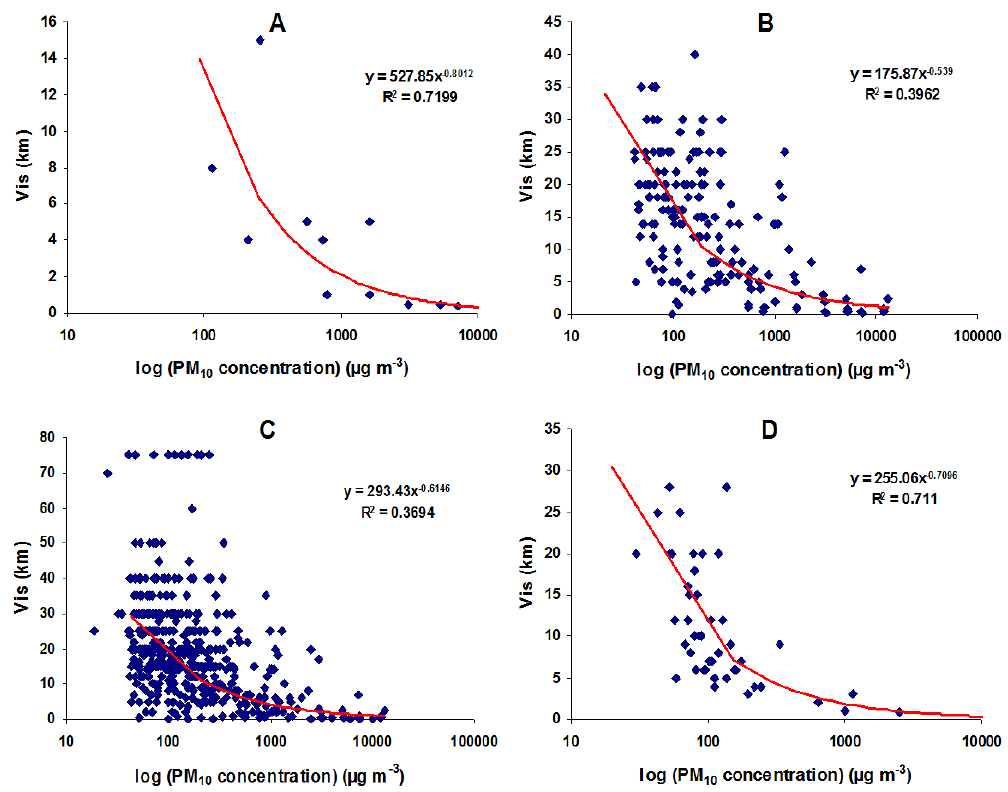
Figure 9. Hourly PM 10 concentrations with corresponding visibility (Vis) at stations: (a) Vík, (b) Vatnsskarðshólar, and (c) all stations (Reykjavík, Vík, Vatnsskarðshólar, and Kirkjubæjarklaustur). (d) represents daily PM 10 concentrations from the high-volume filter aerosol sampler with corresponding minimum 24h visibility at